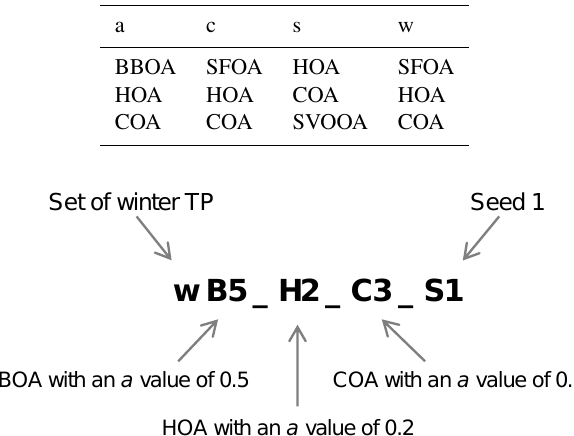
Figure 1. Coding used to identify the different runs.